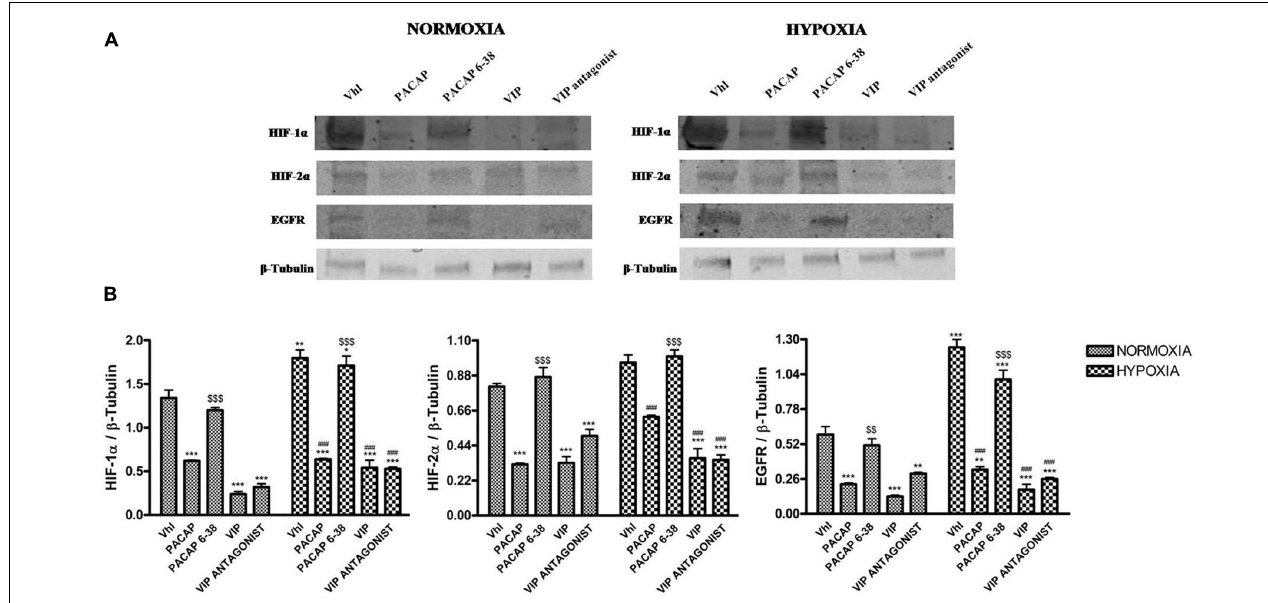
FIGURE 4 | Effect of PACAP, PACAP6-38, VIP, and VIP antagonist on expression of HIF-1 α , HIF-2 α , and EGFR in U87-MG cells under normoxia and hypoxia. (A) Representative immunoblots of HIF-1 α , HIF-2 α , and EGFR expression on U87MG cells grown normoxia or exposed to hypoxia. (B) The bar graphs show quantitative analysis of signals obtained by immunoblots resulting from three independent experiments. Relative band densities were quantified by using ImageJ software. Protein levels are expressed as arbitrary units obtained after normalization to β -tubulin which was used as loading control. Data represent means ± SEM ( ∗ p < 0.05, ∗∗ p < 0.01, or ∗∗∗ p < 0.001 vs. Vhl under normoxia; ### p < 0.001 vs. Vhl under hypoxia $$ p < 0.01 or $$$ p < 0.001 vs. PACAP, as determined by one-way ANOVA followed by the Tukey post hoc